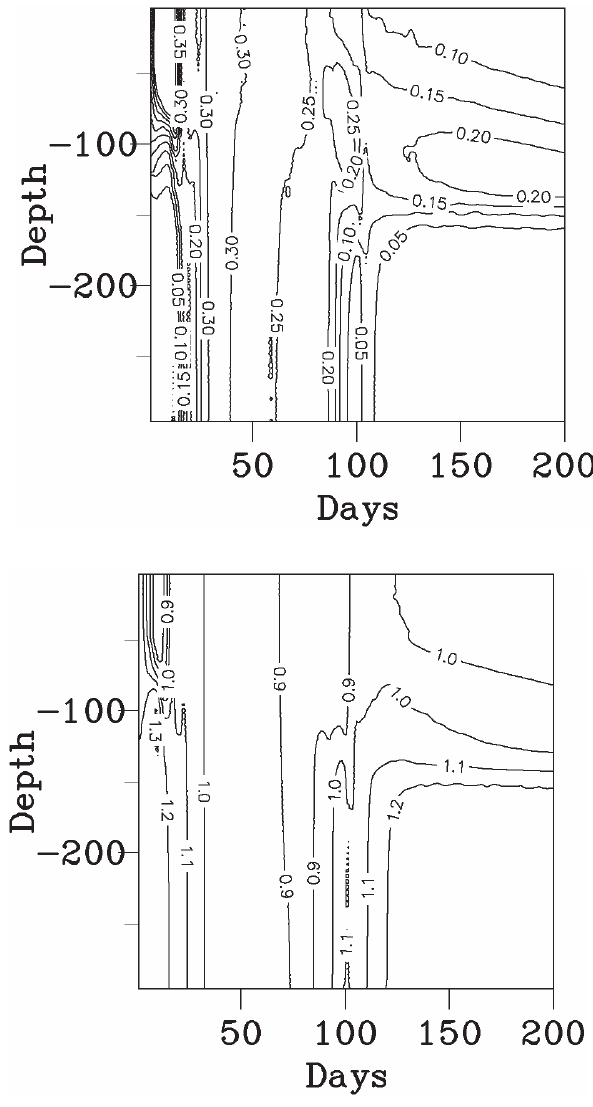
Fig. 4. Time evolution of (a) chlorophyll (mgm − 3 ) and (b) nitrate (mmolm − 3 ) with depth for the reference